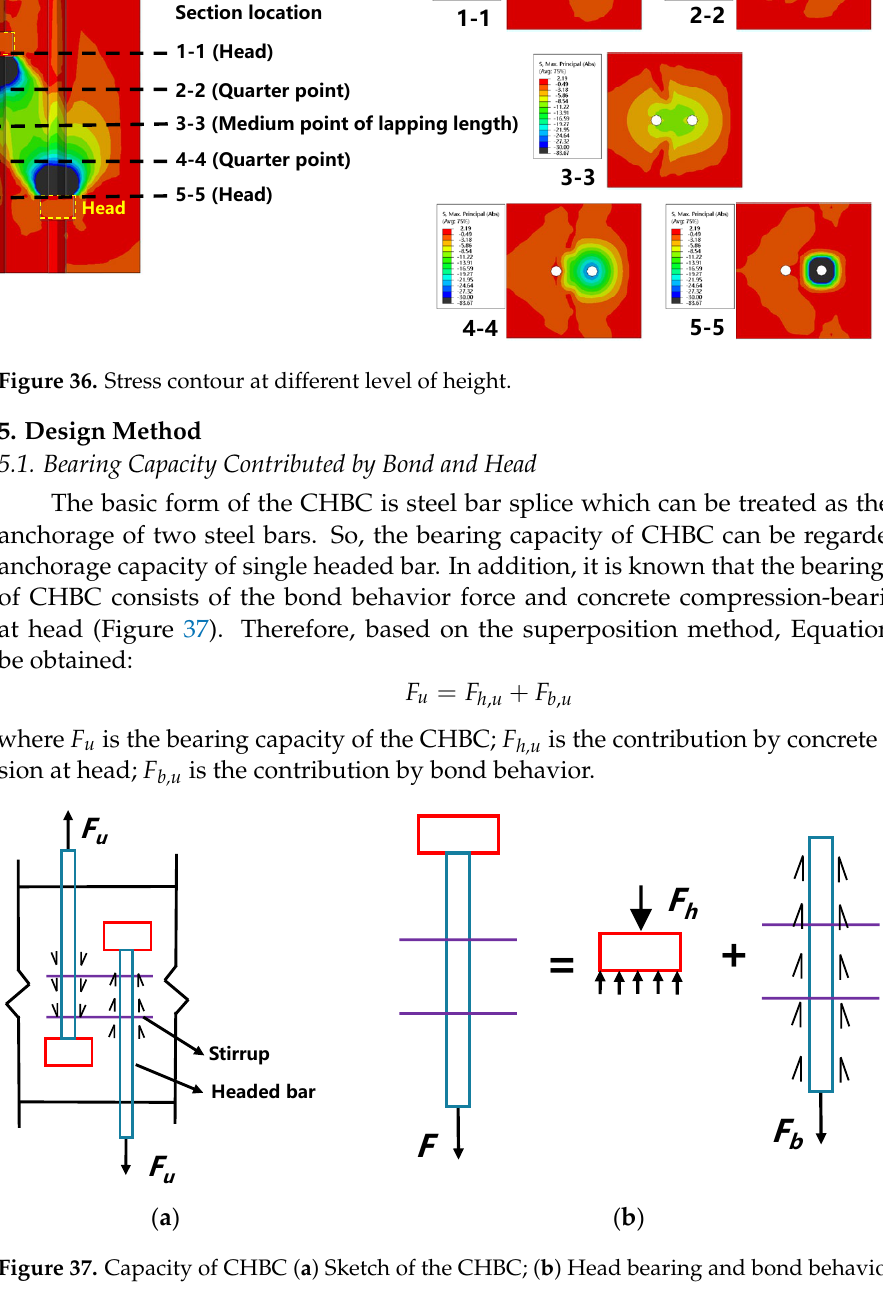
Figure 37. Capacity of CHBC ( a ) Sketch of the CHBC; ( b ) Head bearing and bond behavior.